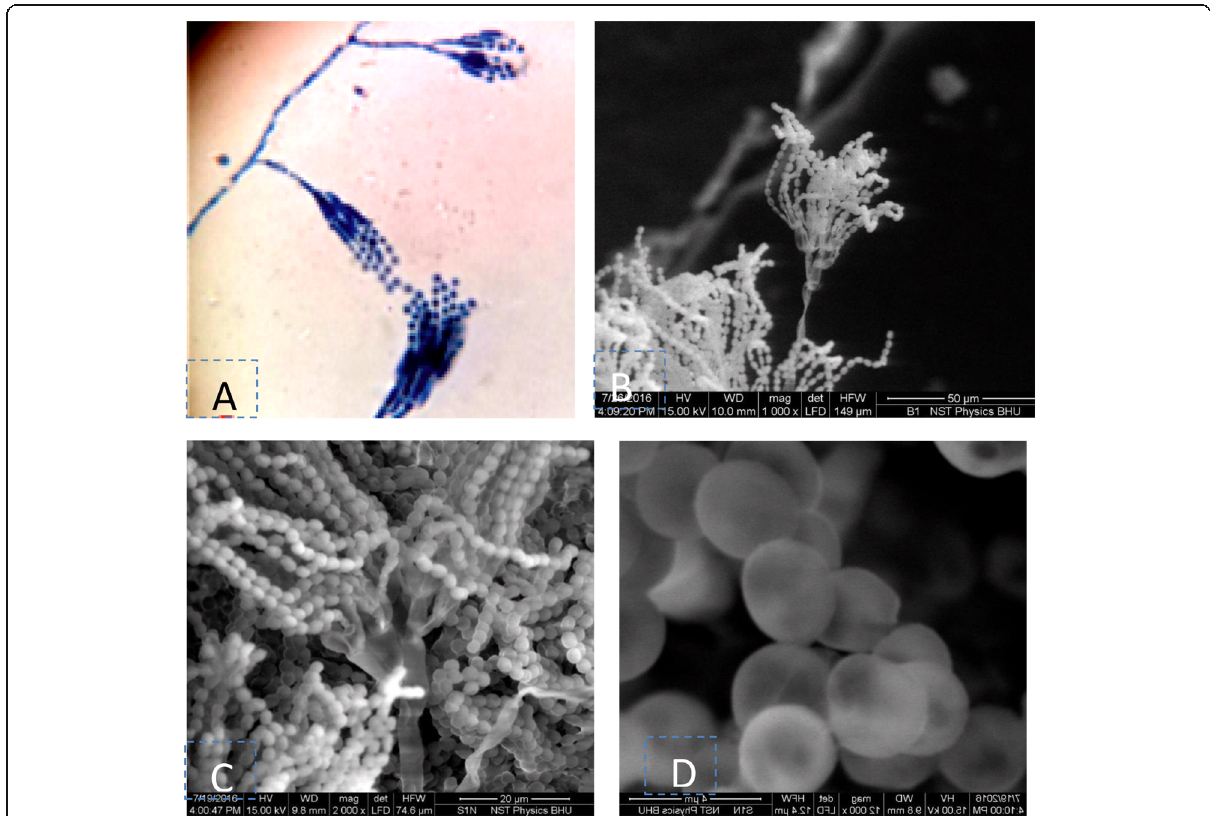
Fig. 4 Spore chain morphology of Penicillium sp. BN-1, a -at 1000X (light microscope); b -ESEM at 1000X; c -2000X; d -Spore surface